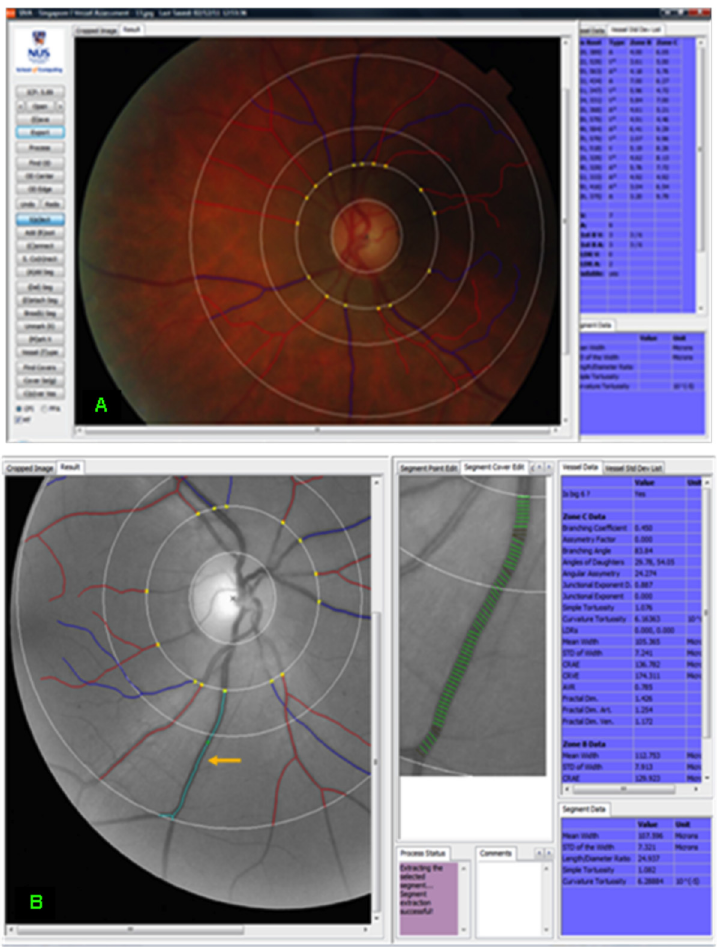
Fig 1. Colour and grey-scale fundus photographs of two different eyes analysed by SIVA. (A) Colour fundus photograph showing optic disc, three concentric subzones, and arterioles and venules, with vessel data. (B) Grey-scale fundus photograph with screen showing multiple measurements of the diameter of the highlighted vessel and vessel data.